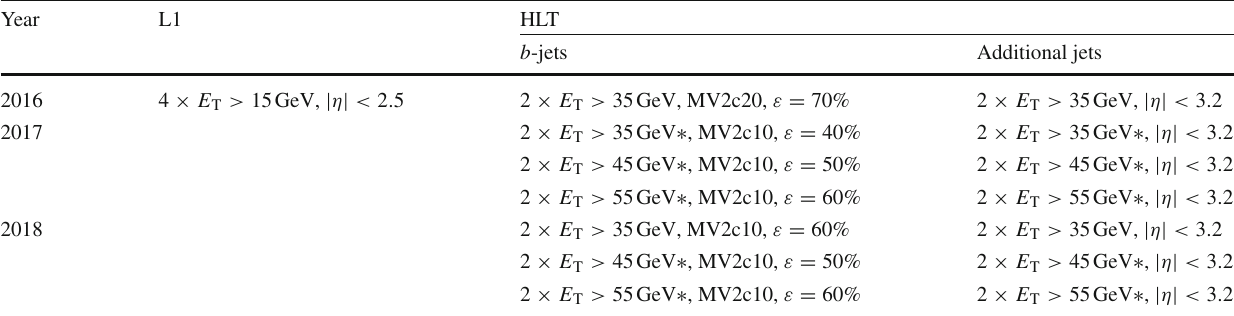
Table 5 Details, by year, of the lowest-threshold unprescaled trig- gers requiring two b -tagged jets plus an additional two jets with no b -tagging requirements. The minimum ( b -)jet E T , | η | , and b -tagging requirements are specified for each item. HLT b -jets are required to be within | η | < 2 . 5. Additional HLT jets are accepted up to | η | < 3 . 2